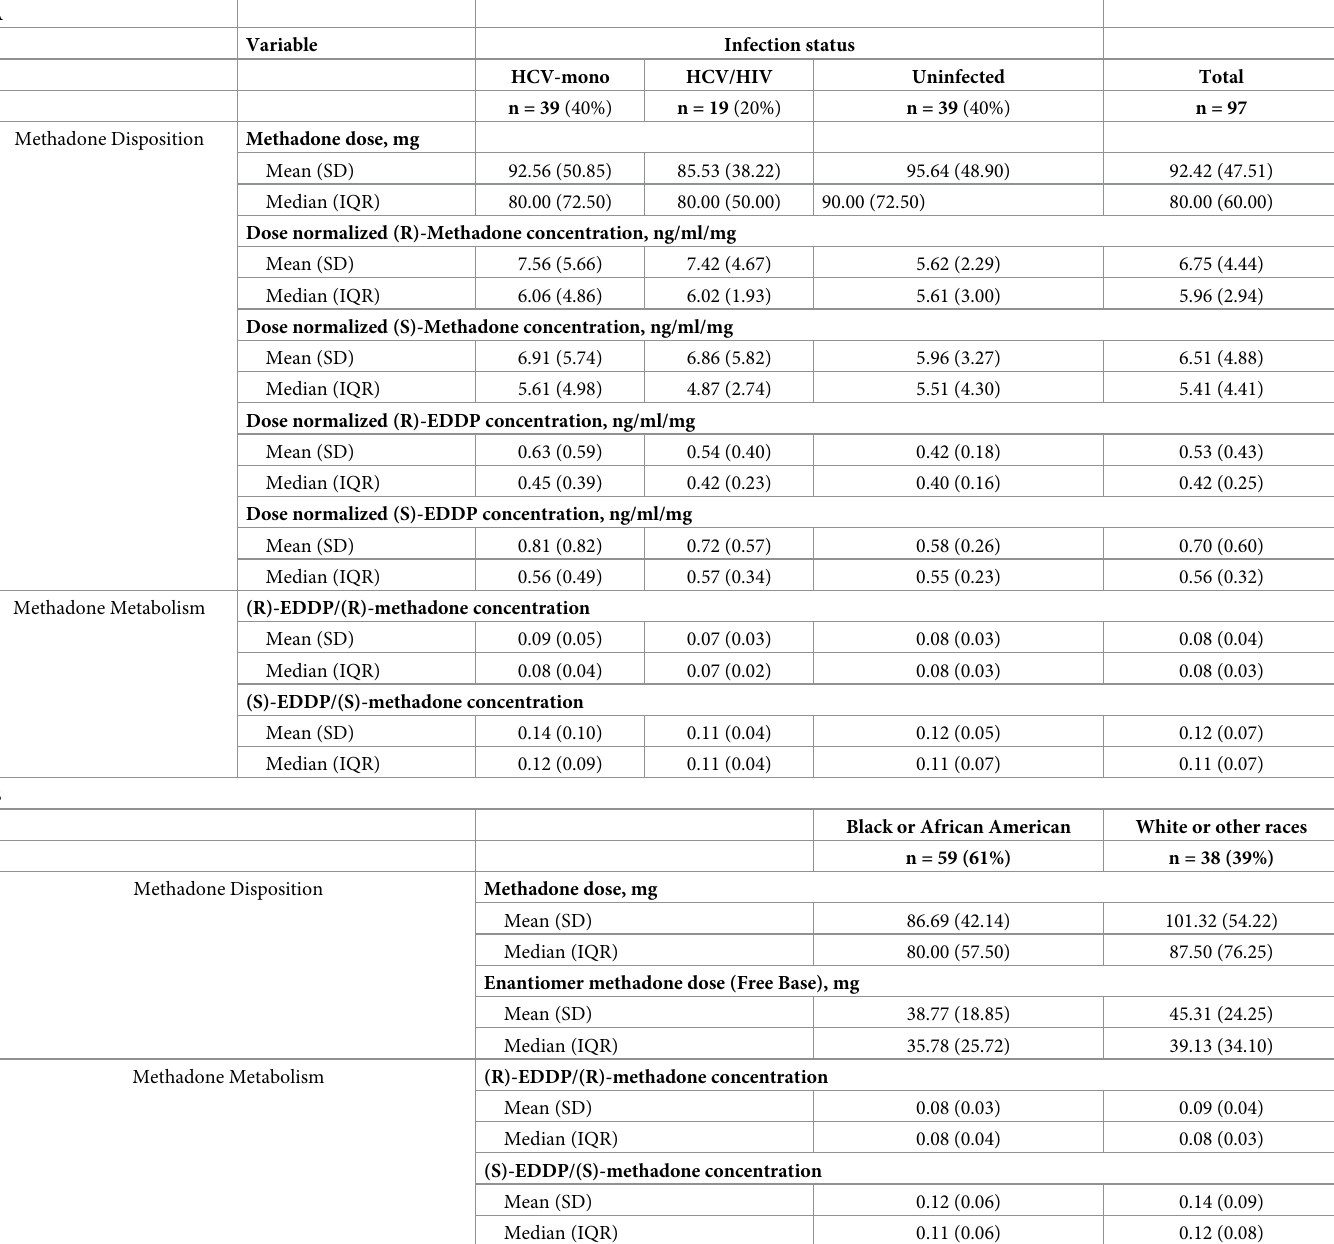
Table 3. A. Methadone dispositionand methadone metabolismmeasurements. B. Methadone dispositionand methadone metabolismmeasurements with respect to race. The table presents counts and associatedpercentages or mean, median and associated standard deviationor interquartilerange as